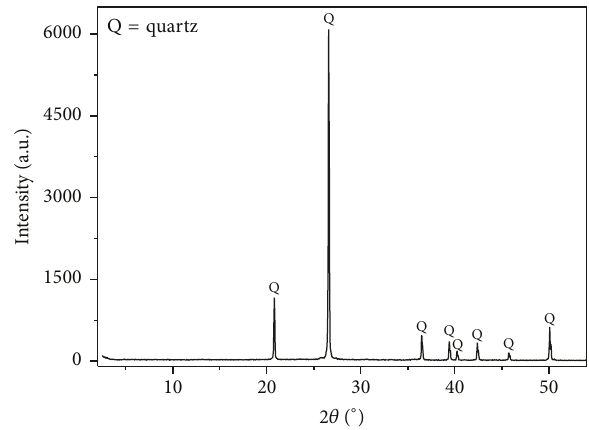
Figure 2: X-ray diffractogram of sugarcane biomass